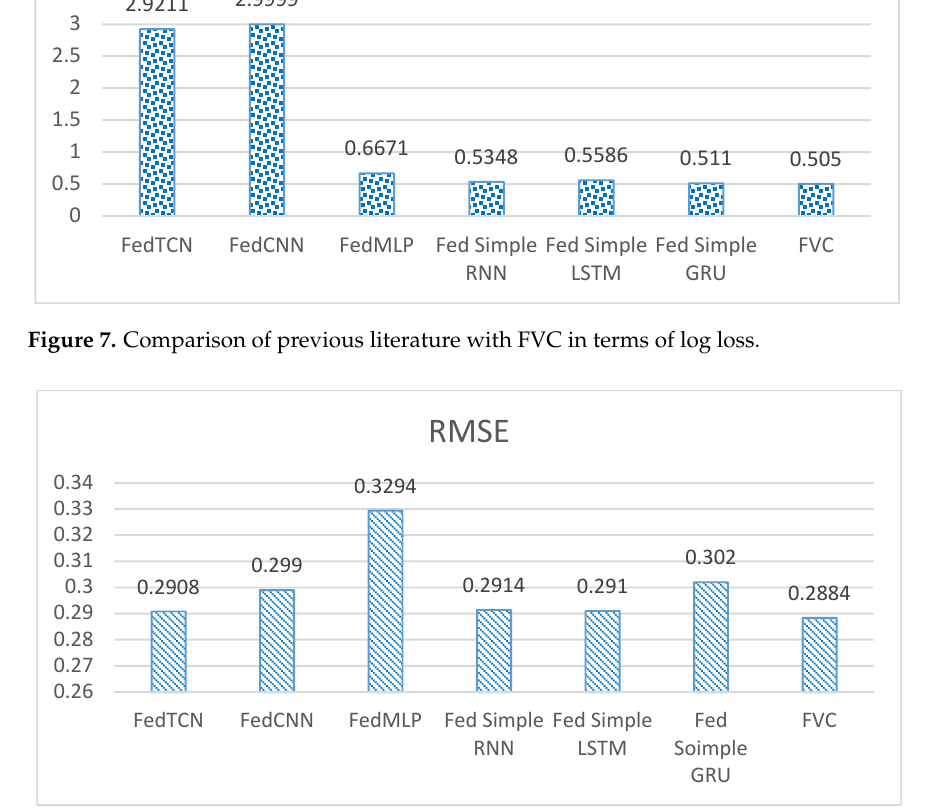
Figure 8. Comparison of previous literature with FVC in terms of RMSE.